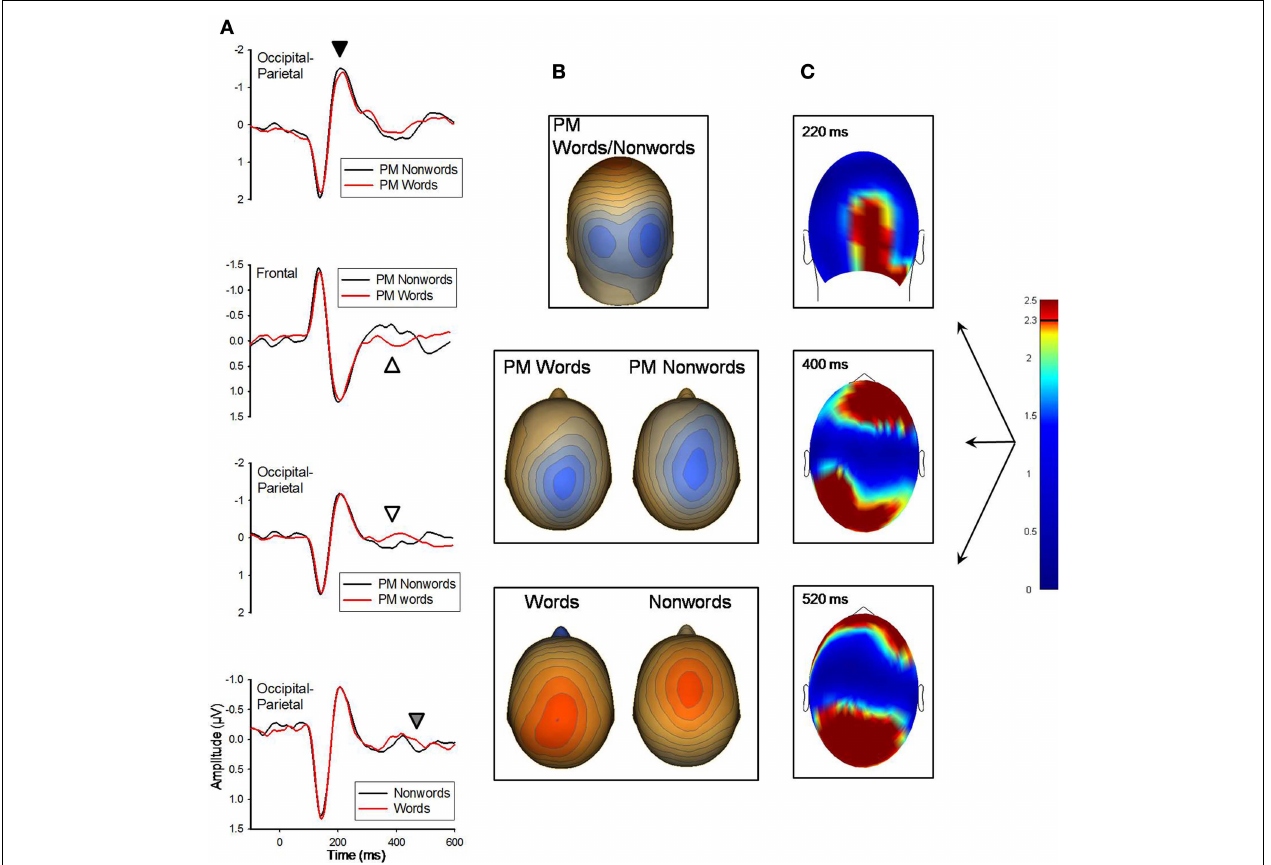
together and presented on one topography for the 220 ms component. PM-words and PM-nonwords are presented separately for the 400 ms effect, and due to similarities in differences across conditions at 520 ms, PM- and LDT-words are averaged together and compared with the average of PM- and LDT-nonwords. (C) Plots of t -values (absolute value taken) over the head surface indicate the sensor clusters for which there were signifi cant effects between PM-words versus PM-nonwords at peaks 220 and 400 ms post-stimulus, and between all words and nonwords at 520 ms post-stimulus. The LDT-words versus LDT-nonwords and PM-words versus PM-nonwords effects are presented together due to the high similarity between the two comparisons at 520 ms post-stimulus. The critical t -value ( t = 2.3281) is marked on the